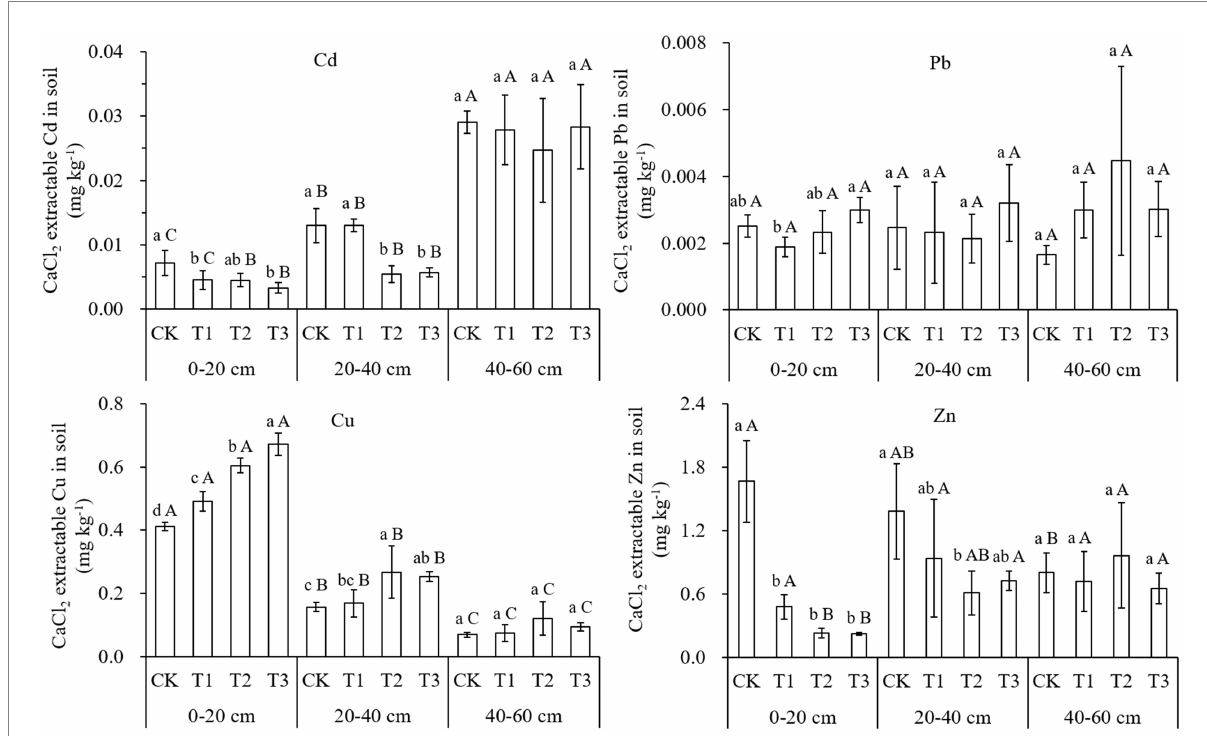
FIGURE 2 Effects of compost application on available concentration of heavy metals in soil (mean ± SD, n = 3). CK, T1, T2, and T3 show compost application at rates of 0, 15, 30, and 45 t ha –1 , respectively. 0–20, 20–40, and 40–60 cm are the depths of soil samples that were taken in the profile. The different lowercase letters indicate significant differences ( p < 0.05) between treatments in each layer, while different capital letters indicate significant differences ( p < 0.05) between soil layers in each